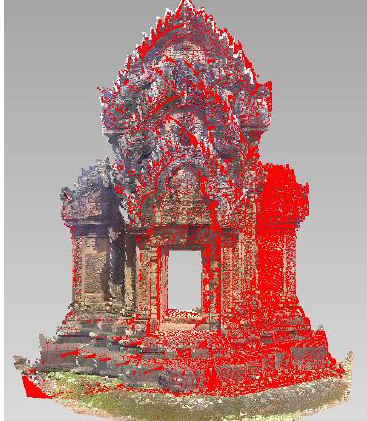
Figure 10. Fine registration result